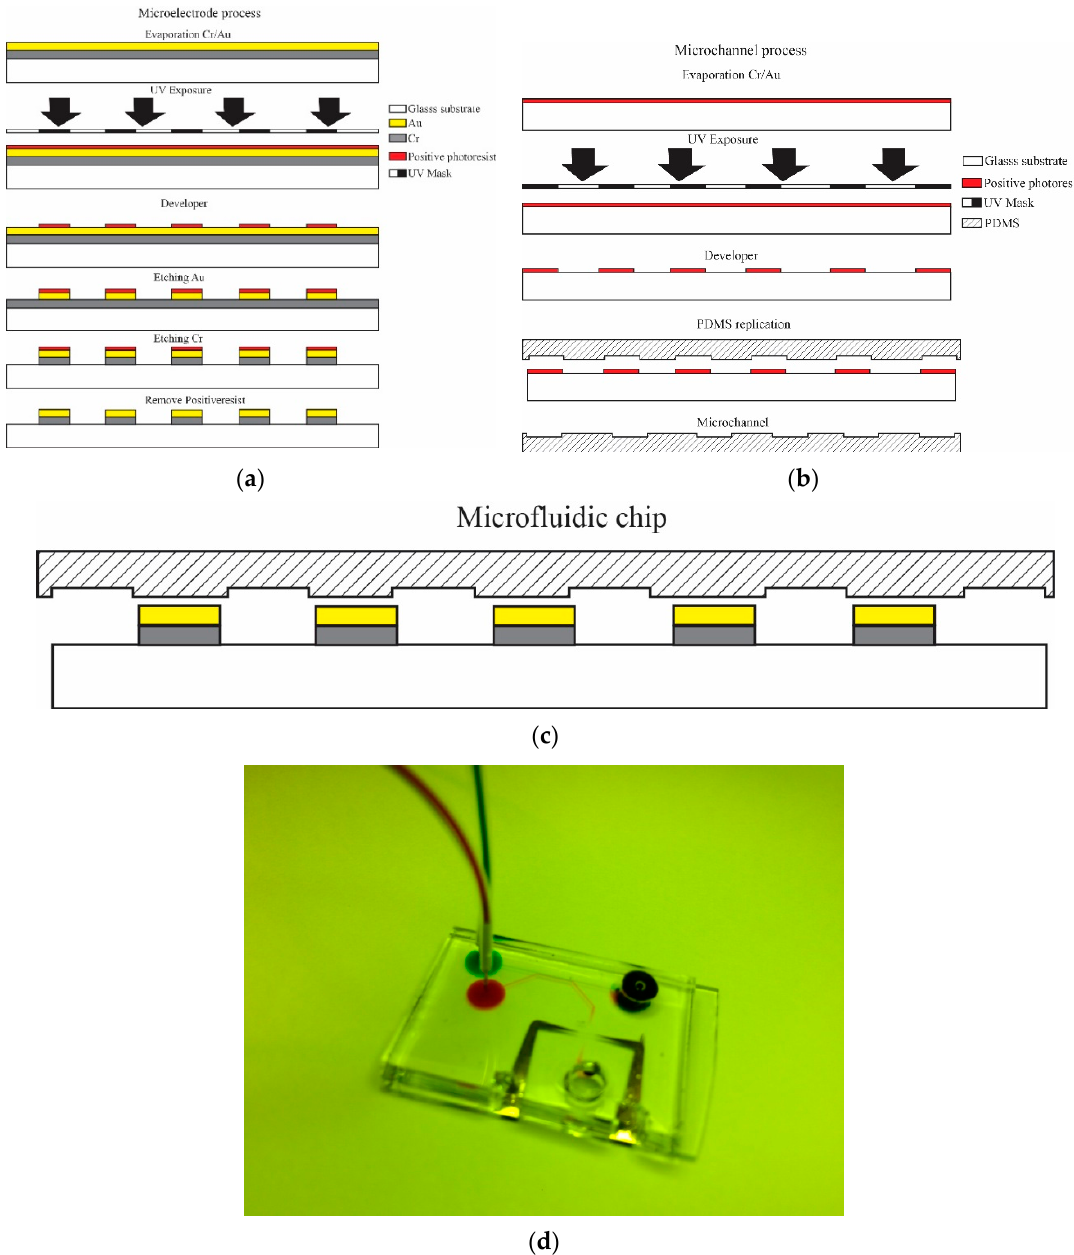
Figure 1. The fabrication of the microfluidic system for sorting and counting motile sperm. ( a ) Fabrication process of a pair of microelectrodes, ( b ) fabrication process of a polydimethylsiloxane (PDMS) microchannel, ( c ) assembly of microfluidic chip, and ( d ) a completed microfluidic system for real-time single cell monitoring.